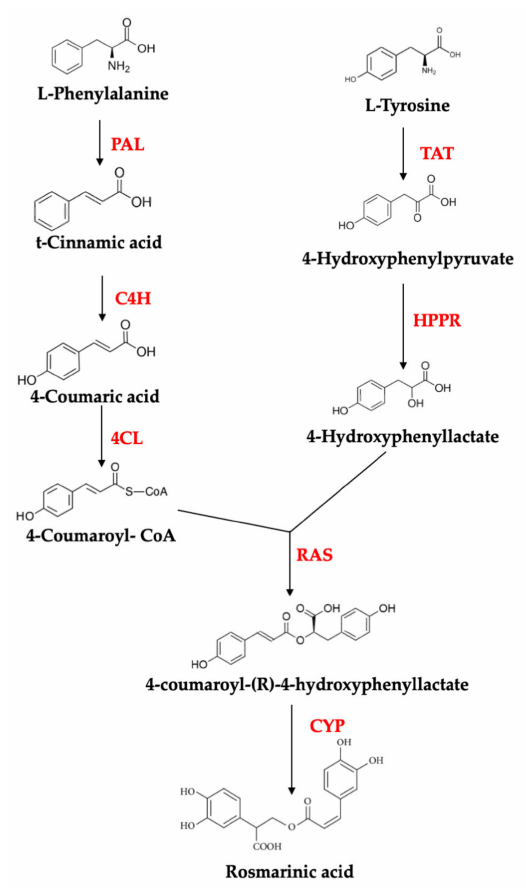
Figure 3. Biosynthetic pathway of rosmarinic